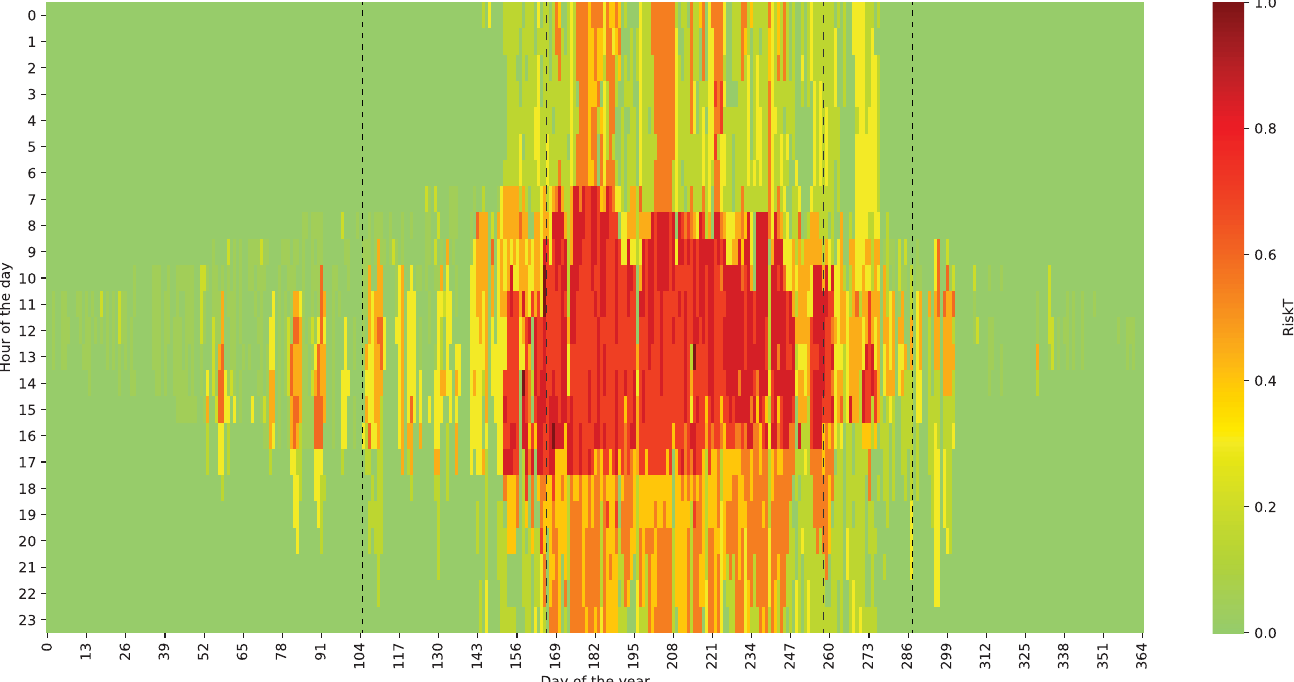
Figure 2. Degree of RiskT from values monitored in 2019 at the station Milano v. Juvara, based on the confluence of disadvantageous conditions of t db − air , I tot , RH , and V a ; which are closely related to the SLOD of increasing